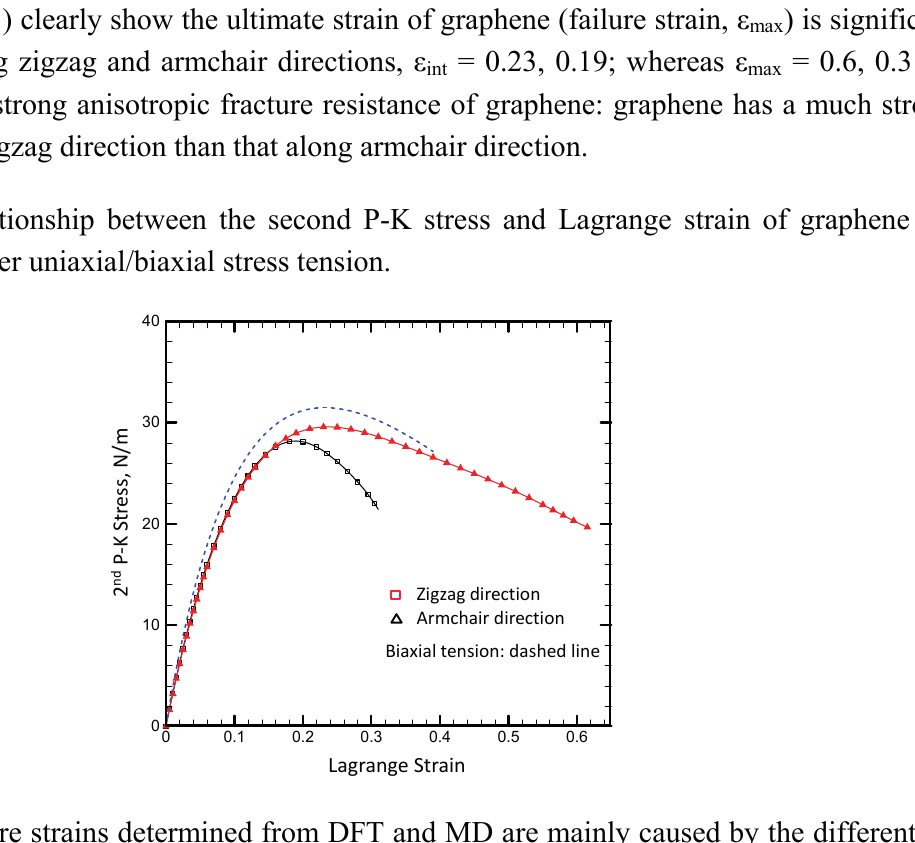
Biaxial tension: dashed